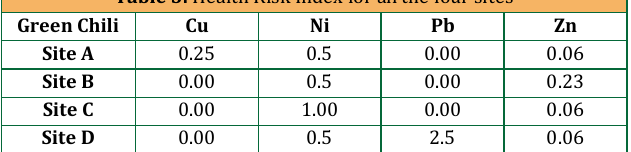
Table 3: Health Risk Index for all the four sites